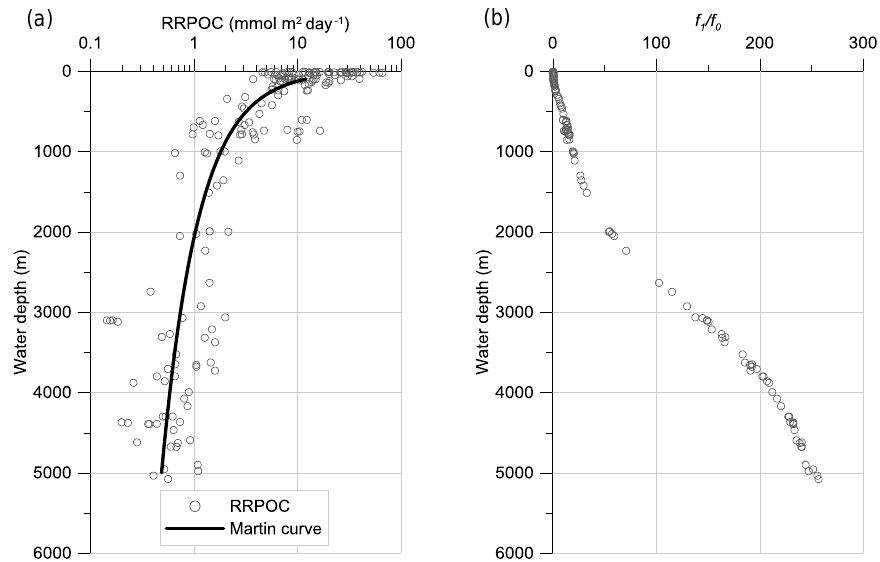
Figure 2. (a) Organic carbon rain rates (RRPOC, Eq. 20) derived for each station in the database versus the Martin curve (Eq. 1). The flux at 100m used to derive the Martin curve is 12mmolm − 2 day − 1 (average of 16 stations between from 90 to 114m water depth). The benthic data are apparently consistent with a Martin coefficient of b = 0.86. (b) The dimensionless ratio f 1 /f 0 (Eq. 12) describing the relative abundance of the reactive POC fraction in sediments (POC 1 ) versus the highly reactive fraction (POC 0 ) . The sigmoidal distribution of the data arises from the dependency of CBE on organic carbon rain rate.